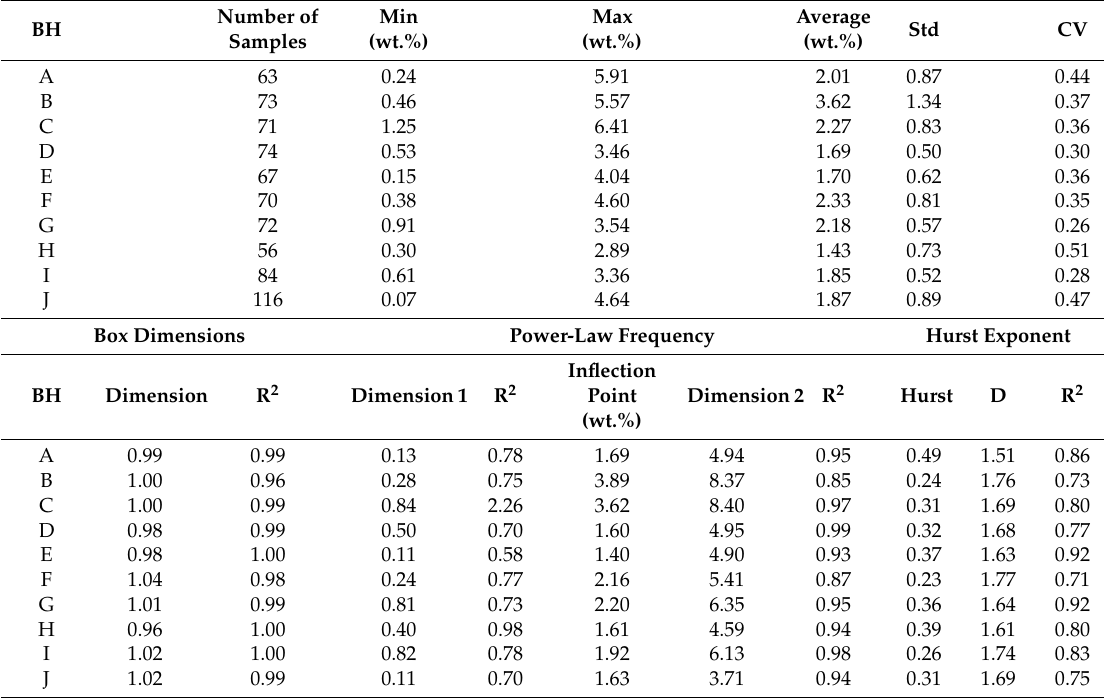
Figure 3. Log–log plots of box size versus number. Table 1. Fractal parameters of the Gulong